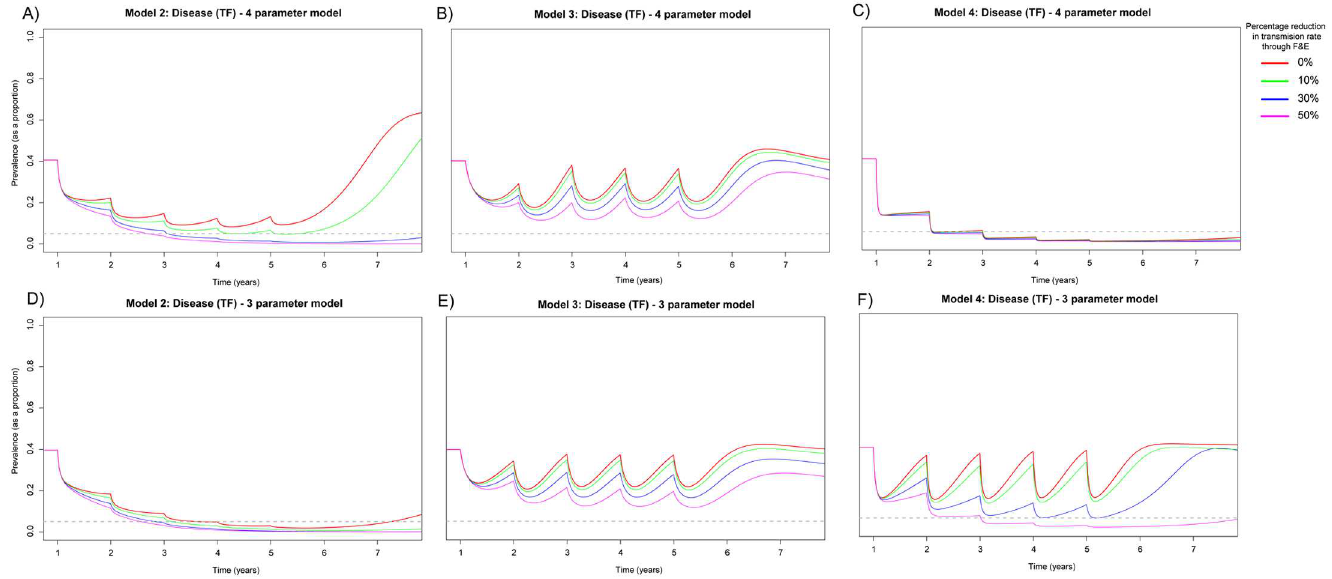
Fig 3. Prevalence of TF in 0–9 year olds when MDA has been applied for 5 annual rounds for 5 yearswithin a community with 40% TF prevalence. A) Model 2 assuming20% susceptibilityto re-infection in the D and assumingan individual’sinfectivity decayedexponentially with each successive infection. B) Model 3 assuming20% susceptibility to re-infectionin the PD and assumingan individual’s infectivity decayedexponentially with each successiveinfection. C) Model 4 assuming80% susceptibility to re-infectionin the D and assumingan individual’sinfectivity decayed exponentially with each successive infection. D) Model 2 assuming 20% susceptibilityto re-infectionin the D and assuminga linear declinein infectivity with each successive infection. E) Model 3 assuming20% susceptibility to re-infectionin the PD and assuminga linear declinein infectivity with each successive infection. F) Model 4 assuming80% susceptibility to re-infectionin the D and assuminga linear declinein infectivity with each successiveinfection. For the 4 and 3 parameter versions of Models 2–4 (A–F) we considered variablereductions in the transmission rate β that may be achievablethrough facial cleanliness and environmental improvements (F&E). We considerinstantaneous non-lineardeclinesin β across the 5 year interventionperiod. We considered maximum reductionsin β over the 5 year interventionperiodto be 0, 10, 30 or 50% from the initial value